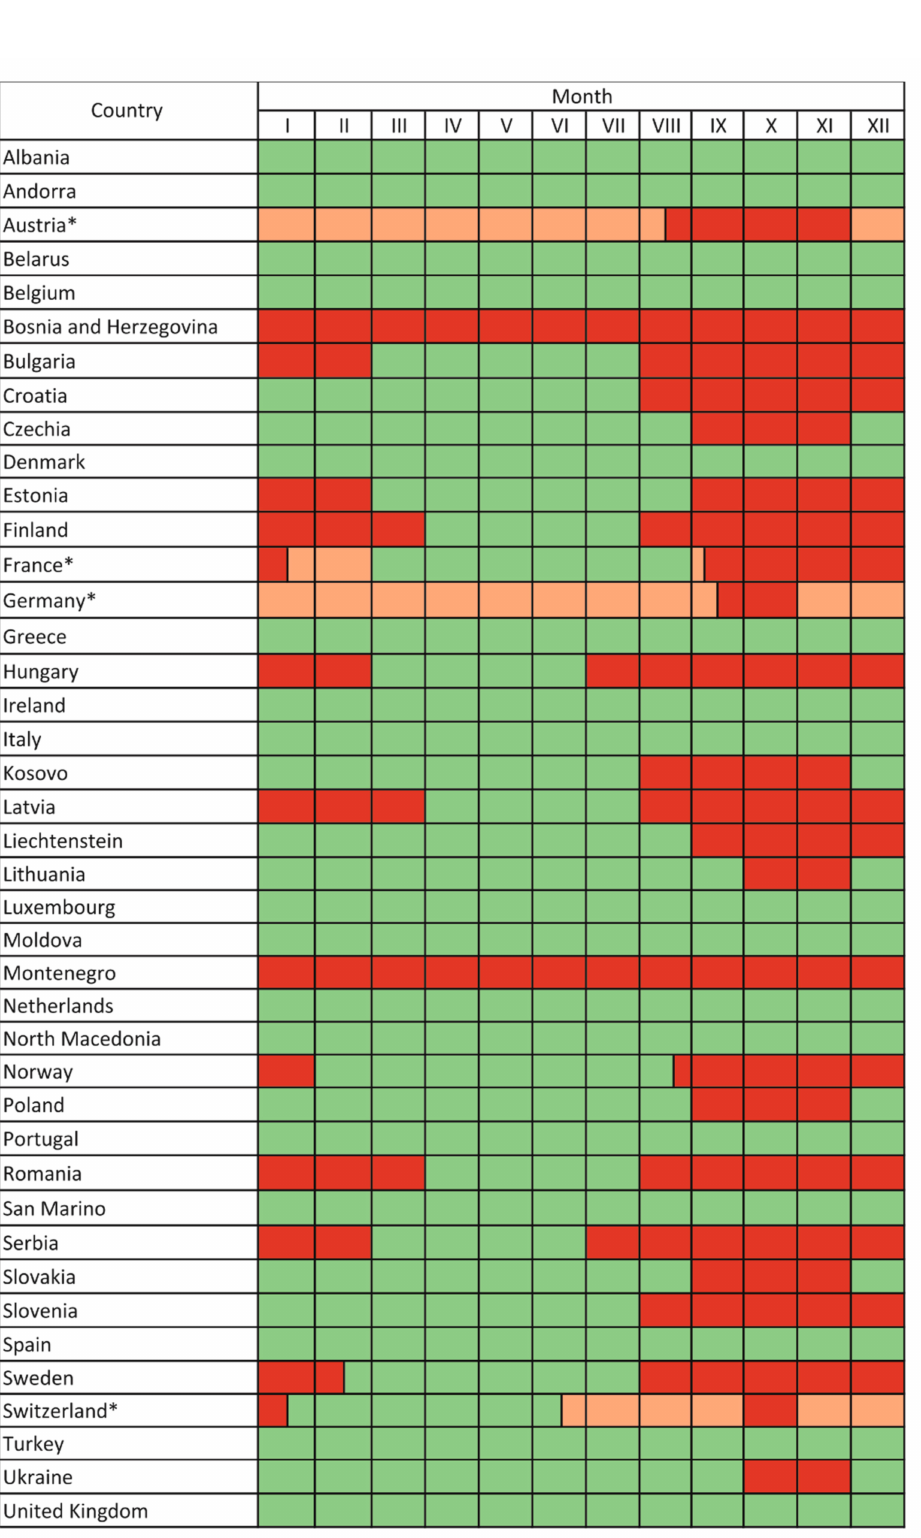
Figure 1. General hunting seasons of the European badger Meles meles in European countries. Green area–species protected or hunting suspended; red area–species hunted; *—countries where hunting period differs between regions (for more details, see Table 1); for these states, minimum (red area) and maximum (pink area) hunting seasons are